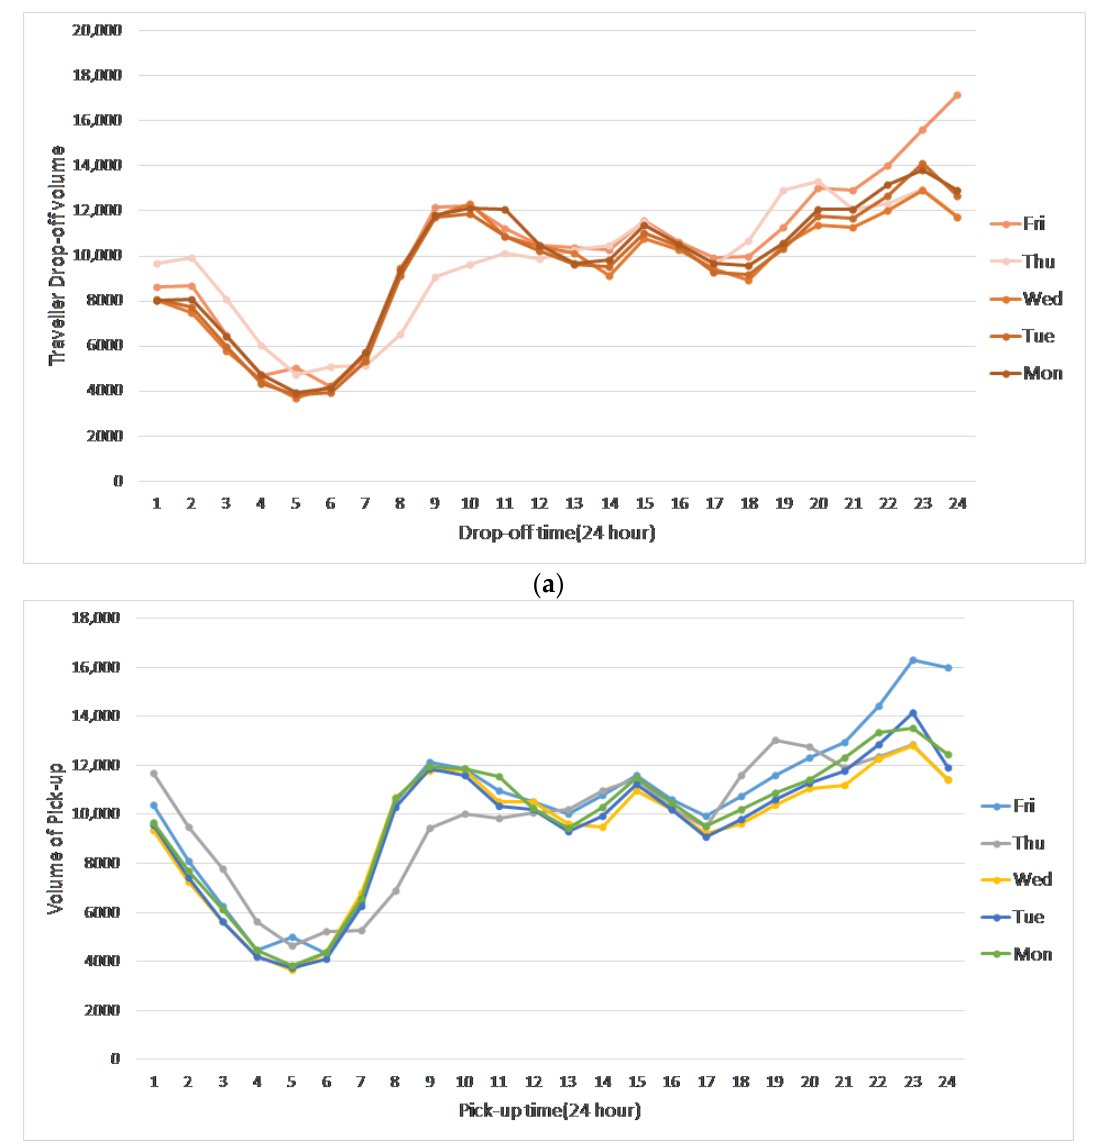
Figure 3. Hourly variation of drop-off ( a ) and pickup ( b ) number (24-h clock). In the research of applying k-means cluster analysis, there are many methods for determining the value of k, and the elbow method is a heuristic method for determining the number of clusters in a dataset. The method plots the explained change as a function of the number of clusters and picking the elbow of the curve as the number of clusters to use [27]. Thus, in our study, we applied the elbow method to help determine a reasonable k value, and Figure 4 illustrates the variation of the cluster deviation of boarding location and travel distance at various periods of the day with the value of k. It can be seen that, when the k value is 8, we could get the best classification effect. The results of the k-means clustering analysis of the travel distance and boarding location are shown in Figure